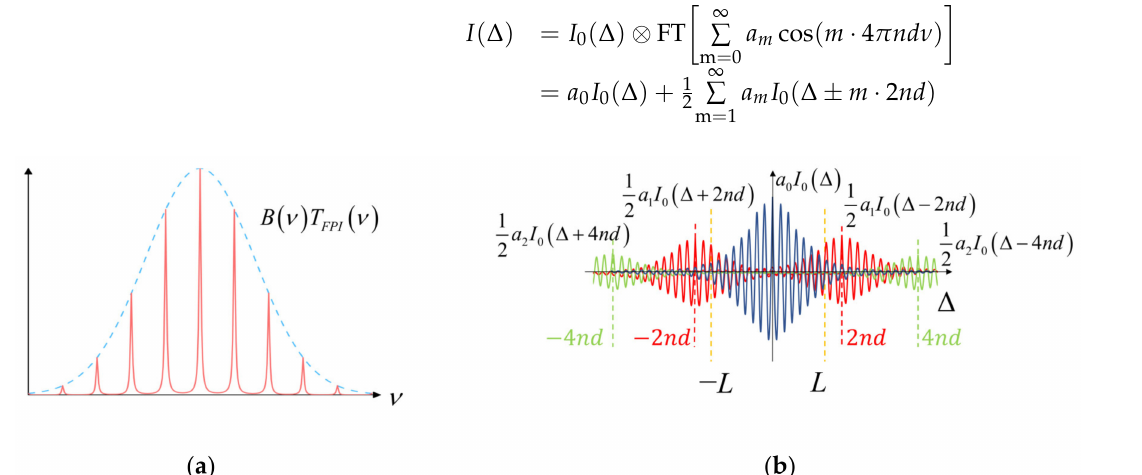
Figure 4. ( a ) The spectrum after FPI modulation; ( b ) the frequency spectrum of the spectrum after FPI modulation; the red curve is the m = 1 order displacement component; the green curve is the m = 2 order displacement component, and other higher order displacement components are omitted from the